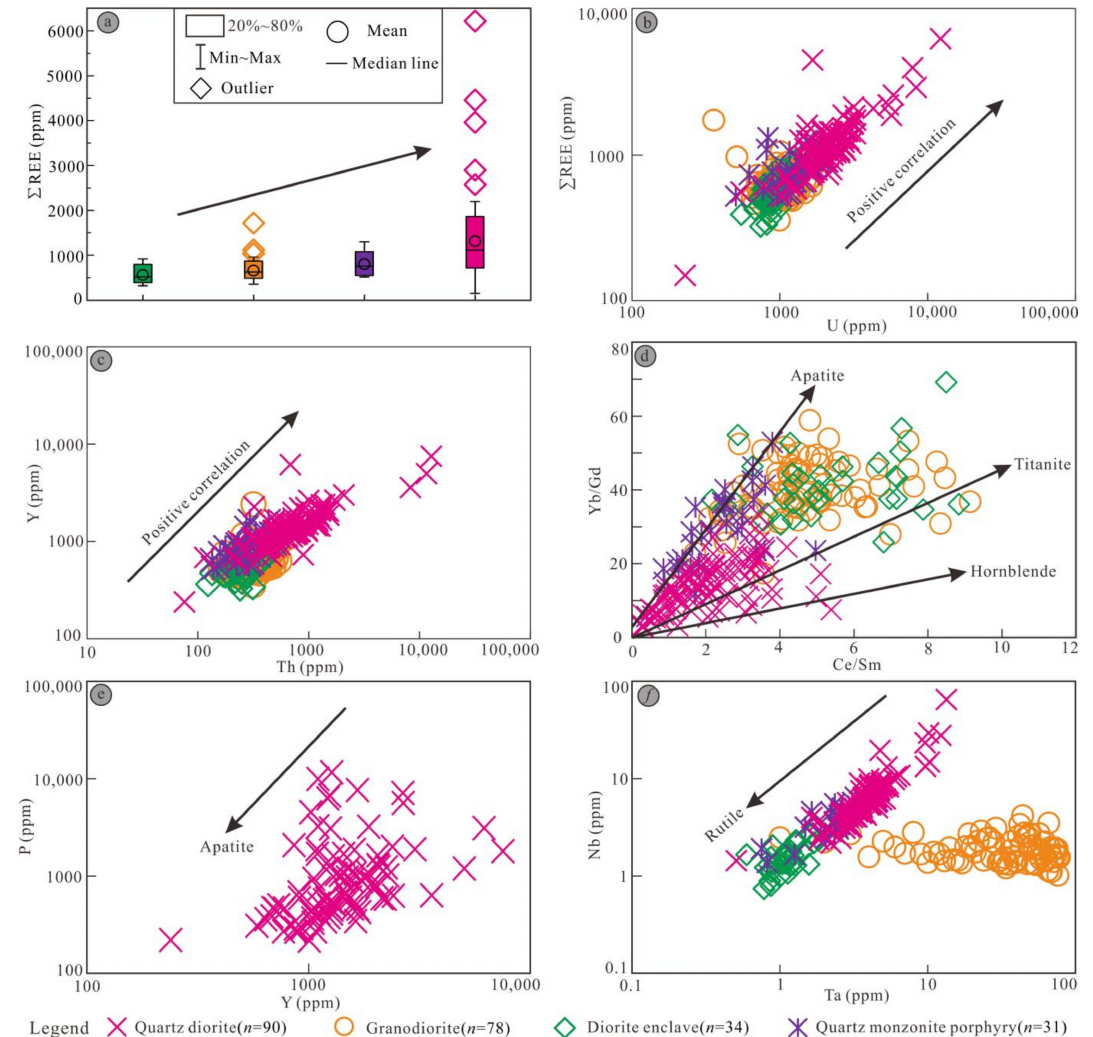
Figure 16. The indication diagram of magmatic zircons trace elements on magmatic mineral fractional crystallization of Yangla granitoid plutons. The dioritic enclaves, granodiorite, and quartz monzonite porphyry zircons data from Ref. [3]. ( a ) the comparative box plots for the zircons ∑ REE; ( b ) the binary diagram of zircons ∑ REE vs. U; ( c ) the binary diagram of zircons Y vs. U; ( d ) the binary diagram of zircons Yb/Gd vs. Ce/Sm; ( e ) the binary diagram of zircons P vs. Y; ( f ) the binary diagram of zircons Nb vs.